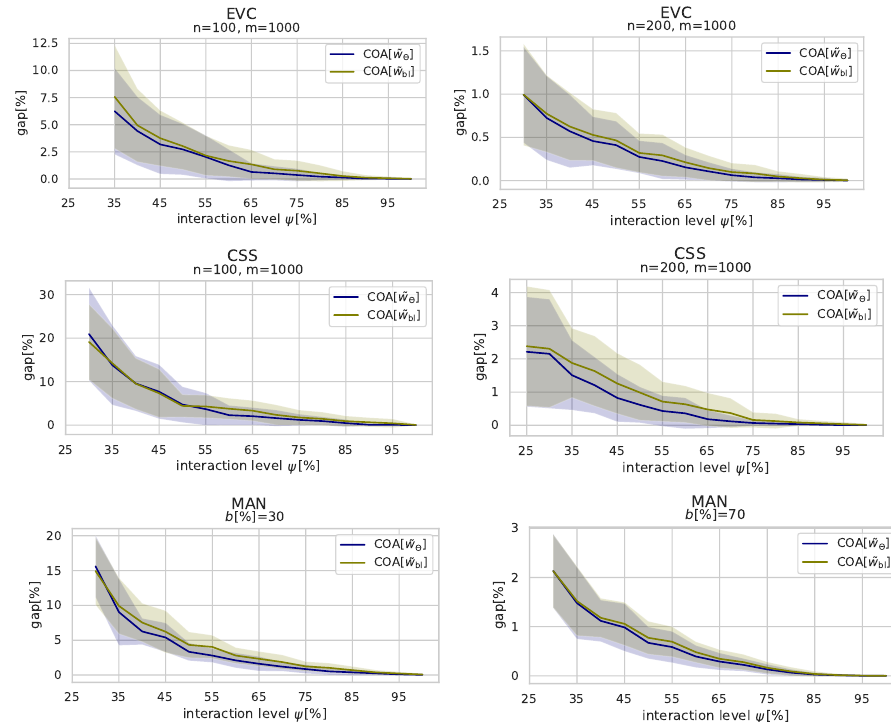
Figure 6. Average optimality gaps with standard deviations as shaded areas obtained by COA using the surrogate suitability functions with learning capabilities ( ˜ w Θ ) and without ( ˜ w bl ) plotted over the interaction level.